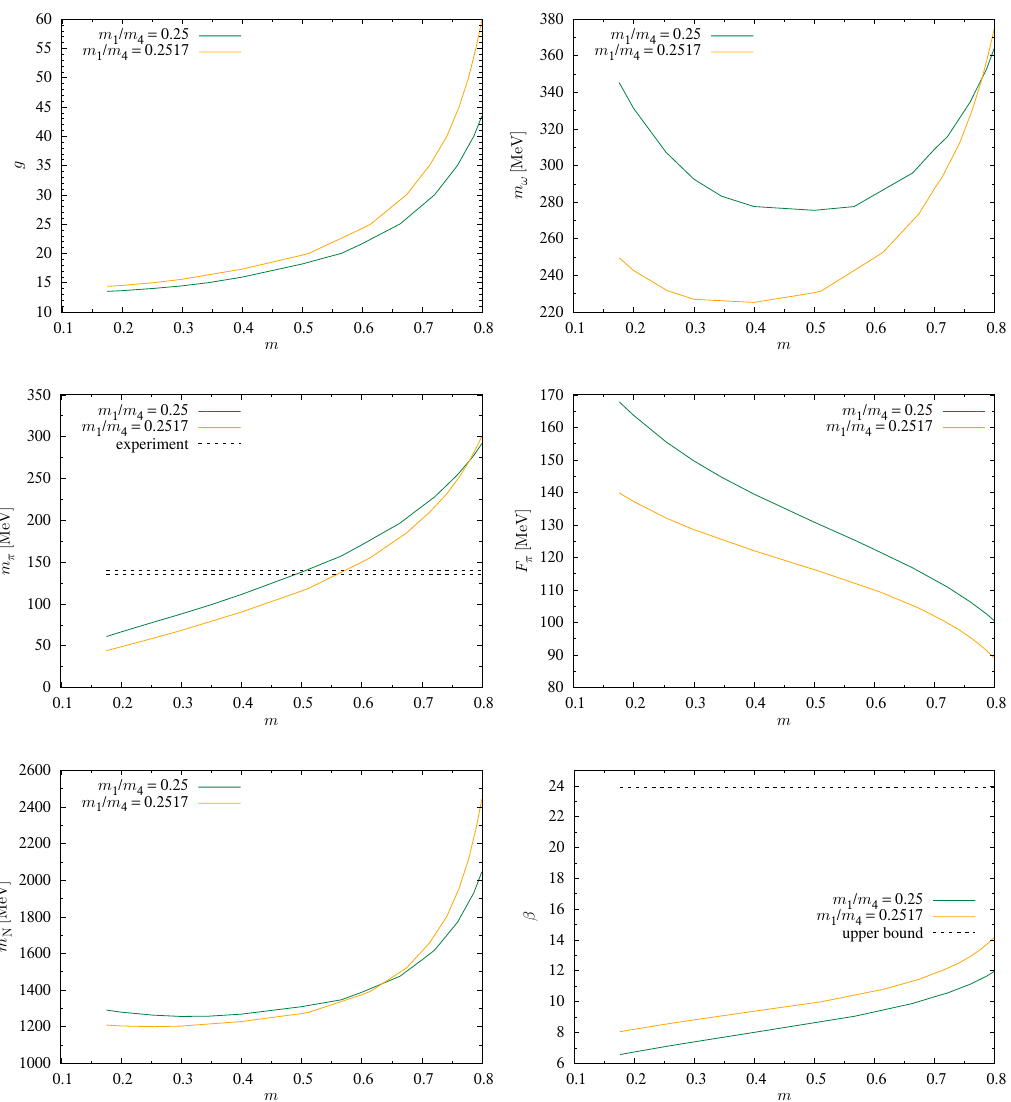
Figure 6 . Solutions that (cid:12)t to the nucleon radius and the helium-4 mass with classical mass ratios m 1 =m 4 = 0 : 25 ; 0 : 2517. The panels show the coupling constant g , the omega mass m ! , the pion mass m (cid:25) , the pion decay constant F (cid:25) , the nucleon mass m N and the physical coupling constant (cid:12) .